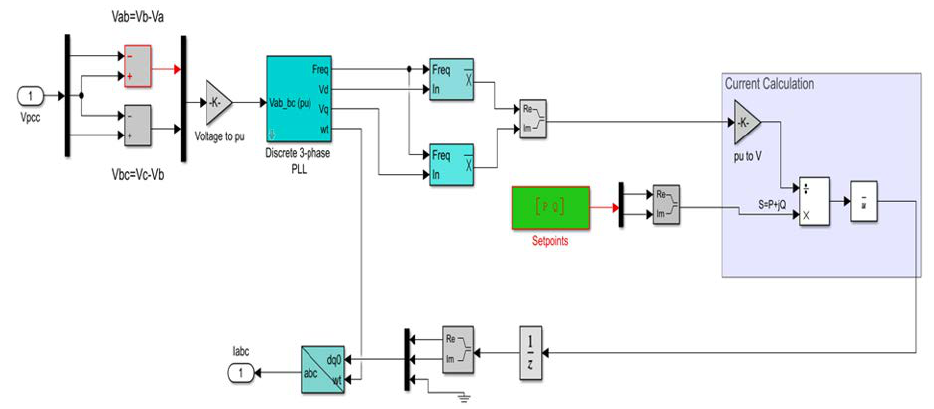
Figure A3. Current evaluation for the hardware under test (HUT) based on power set-points and voltage at the point of common coupling (PCC) in